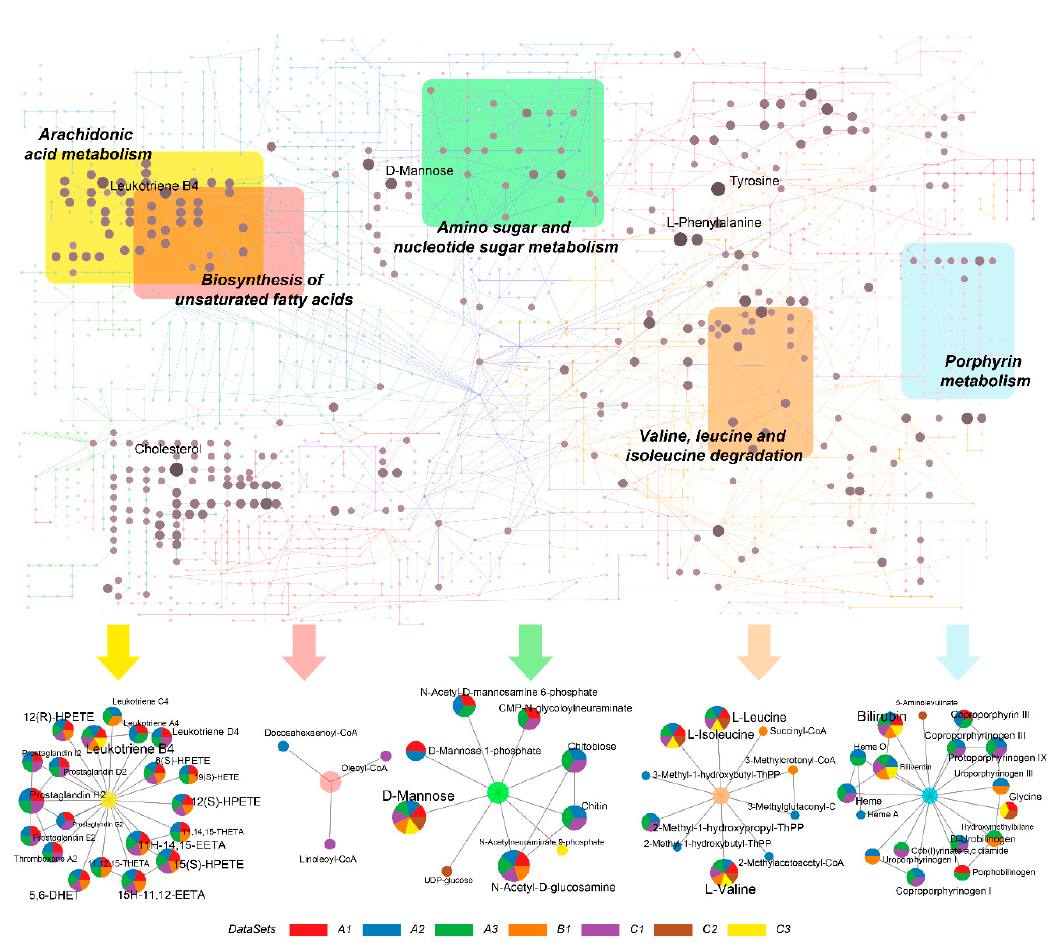
Figure 4. Overview of potentially perturbed metabolites and extracted metabolic pathways based on the seven datasets. The top five pathways ranked by their integrated p -values are shown here. The top part is the KEGG global metabolic map, with nodes in brown showing the matched metabolites whose sizes are based on the total number of hits from different datasets. Different colored areas represent different pathways. At the bottom are the five extracted pathways corresponding to the five colored regions in the map, with nodes shown as pie charts whose sizes and components correspond to the hits from different datasets.